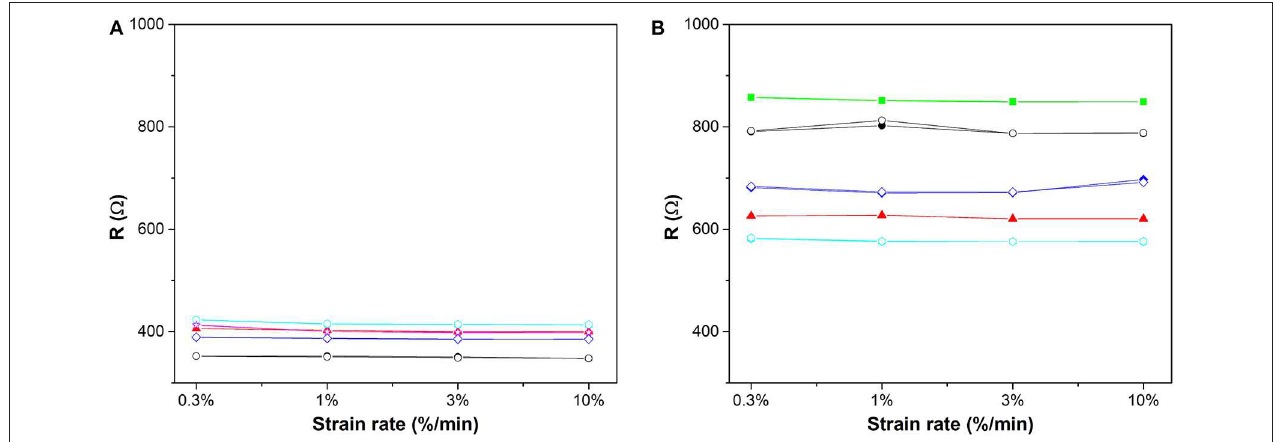
FIGURE 6 | Resistance of 3D-printed parts before (open symbol) and after (closed symbol) applied mechanical strain at different strain rate tests: HC (A) and H45 (B) . The error is lower than about 1%.